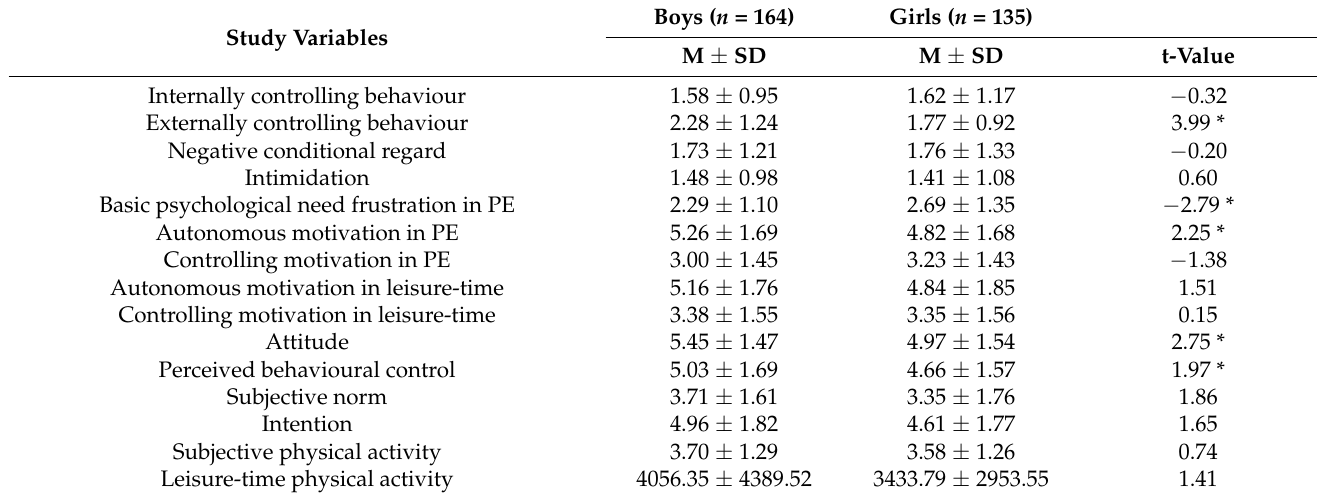
Table 3. Gender differences in study